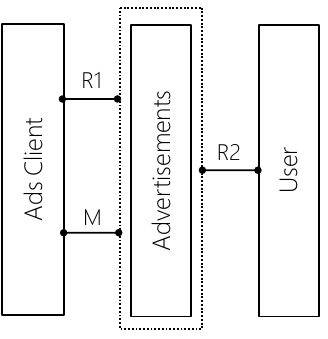
Figure 27. Advertising